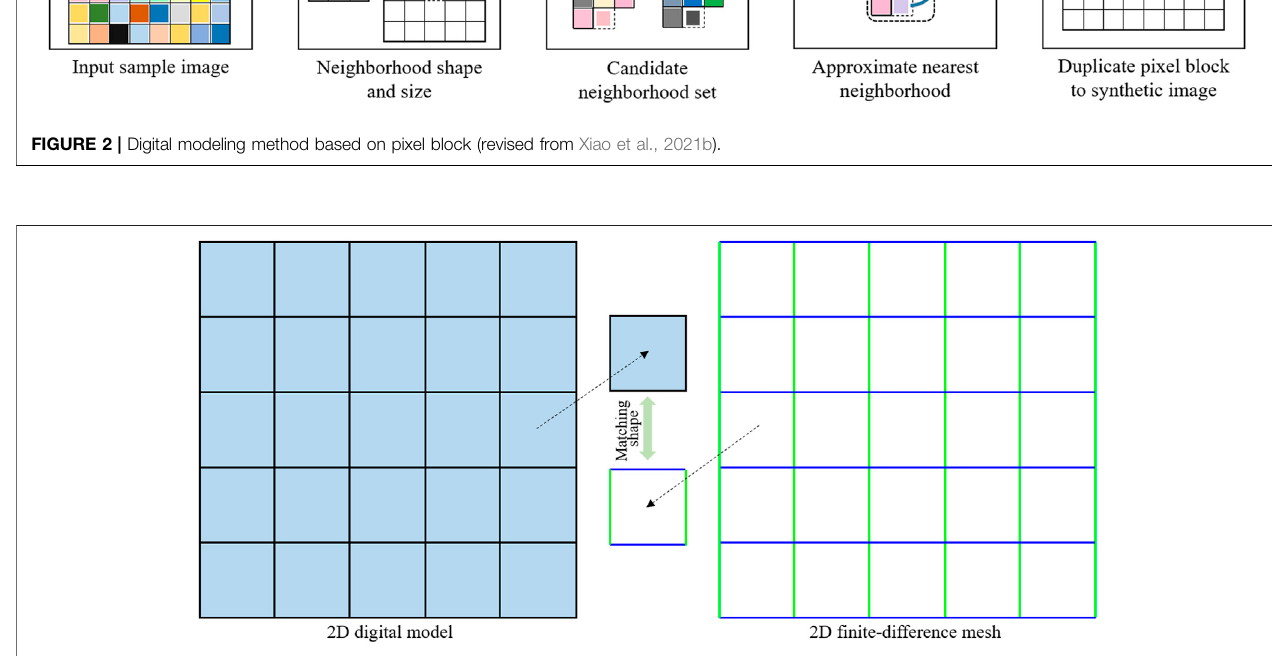
FIGURE 3 | The mapping relationship between the digital model and fi nite-difference